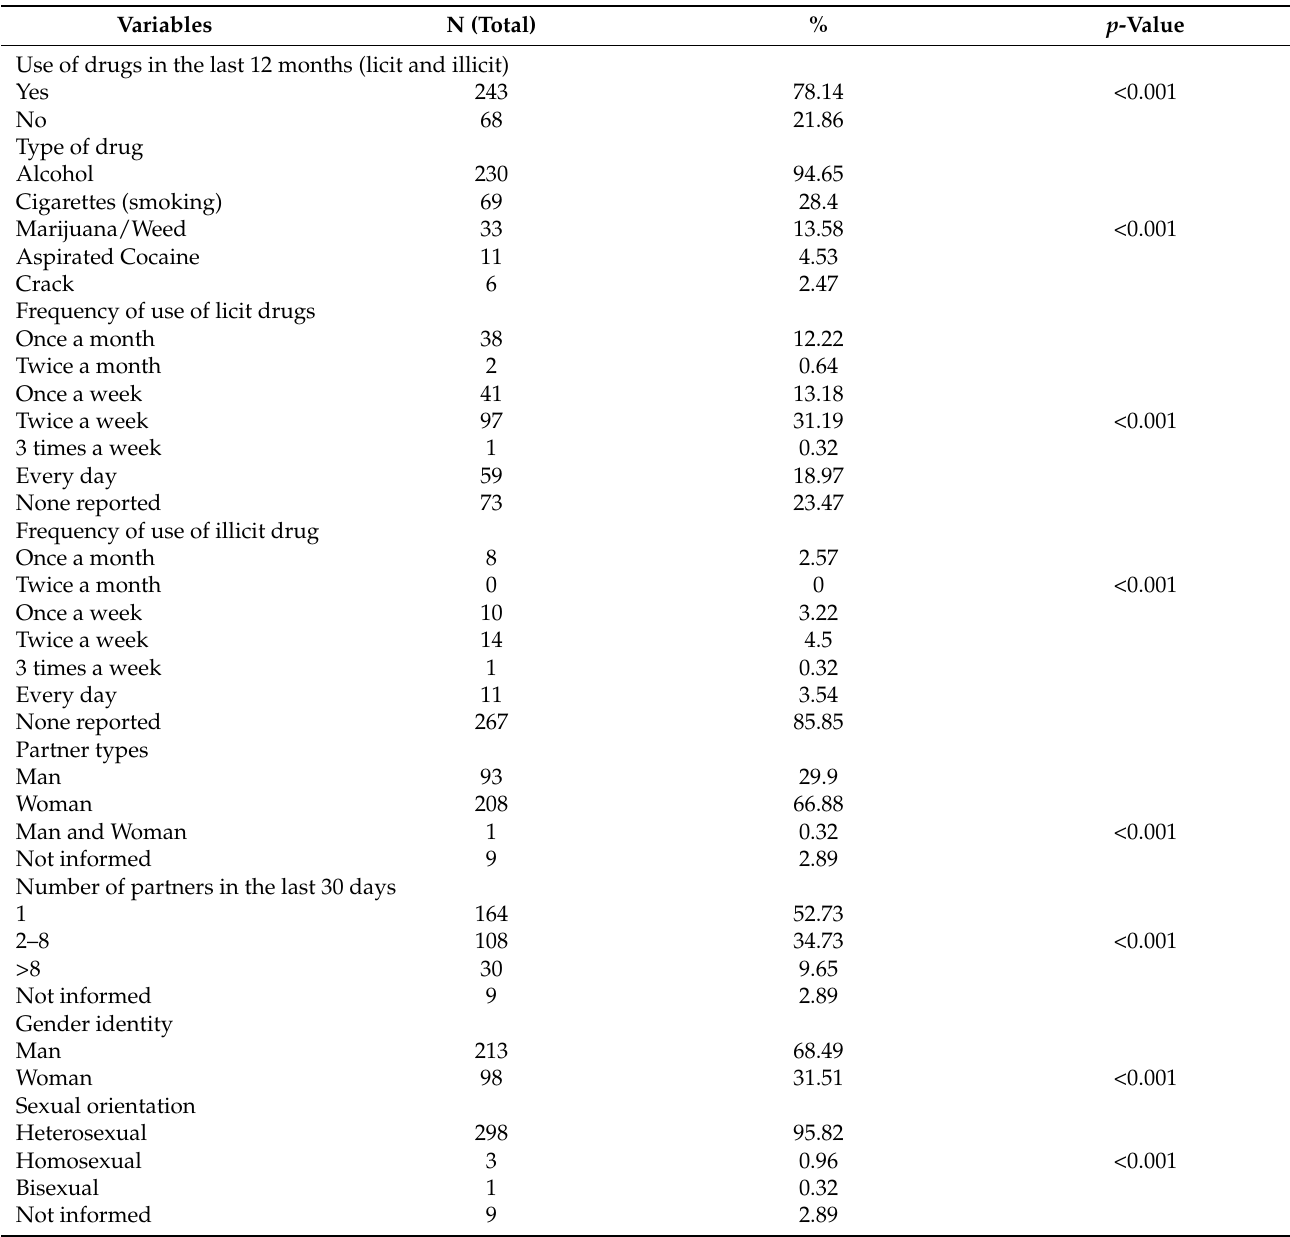
Table 4. Behavioral characteristics of malaria-positive individuals from a mining area in the Brazilian Amazon. Variables N (Total)